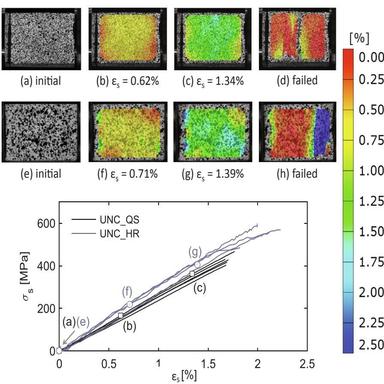
Stress strain curves in compression and longitudinal strain fields for a representative specimen in QS (a)–(d) and HR (e)–(h) loading.